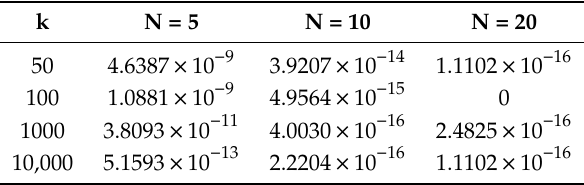
Table 1. Absolute error for κ = 0, bounded at x = 1.